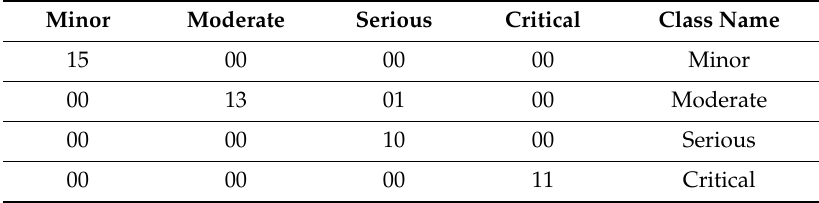
Table 17. Confusion Matrix for fold